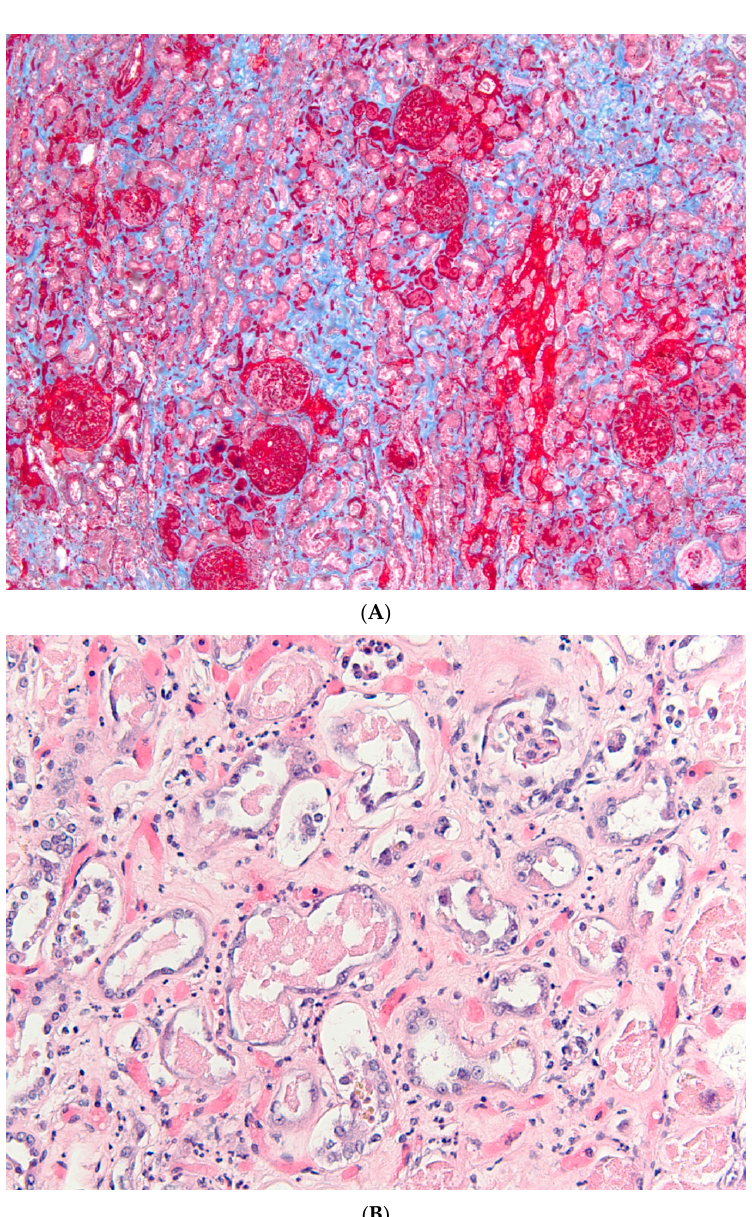
Figure 1. Renal cortical morphology of type I ischemic AKI. Resuscitation was initiated in a 71 years old patient with AMI who remained pulseless for an hour before the restoration of effective cardiac rhythm. The patient’s blood pressure was only briefly maintained by intravenous pressors, but he